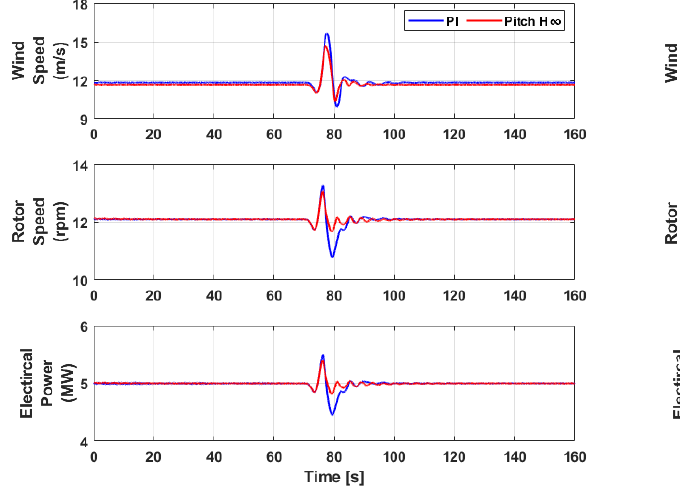
Table 5. Comparison of NTM results for performance data in 18 m/s noisy environment.